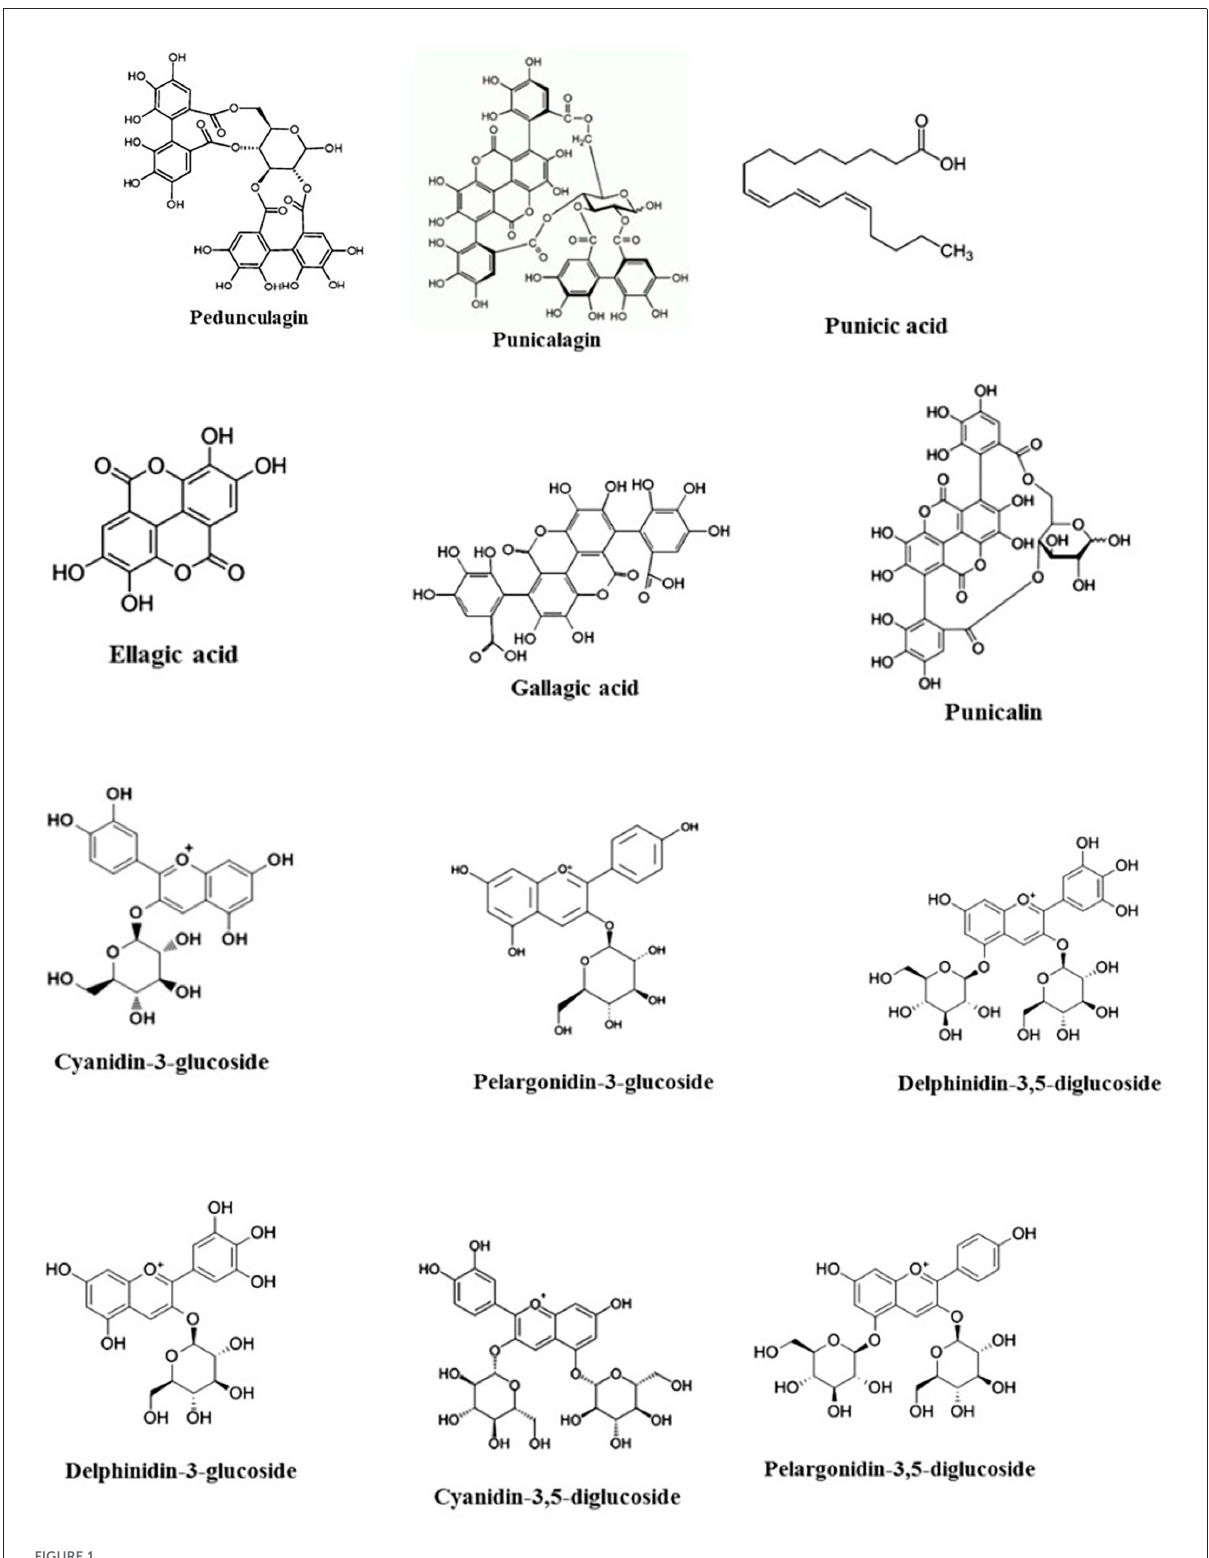
FIGURE1 Chemical structures of main components of